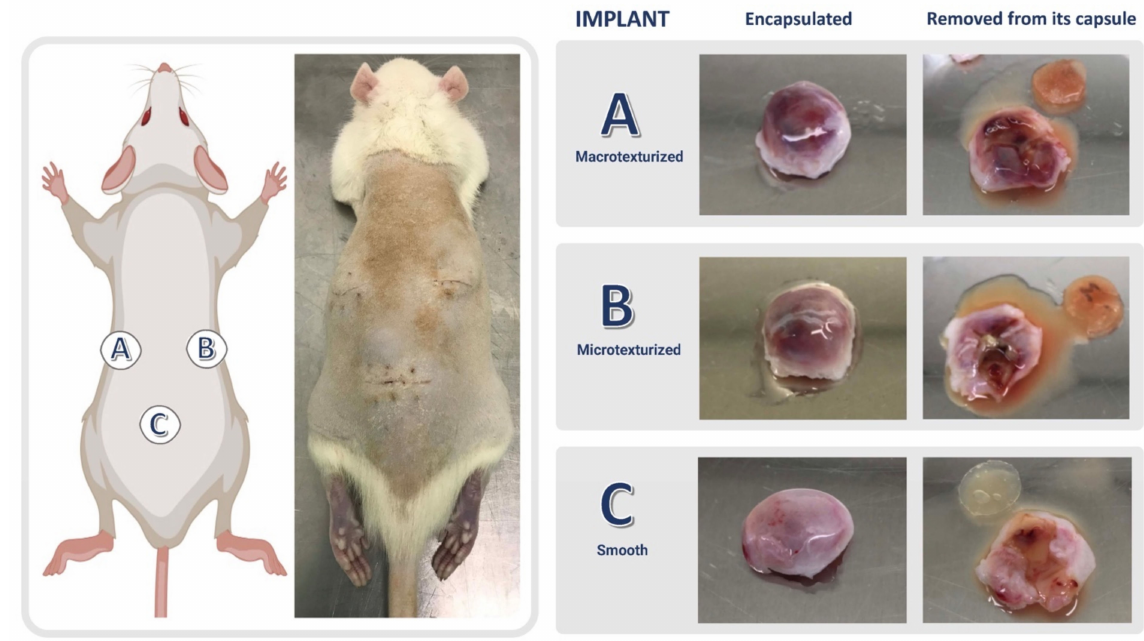
Figure 2. Location of implants in the Wistar rat (( A ) macrotexturized, ( B ) microtexturized, ( C ) smooth). Macroscopic appearance of the capsules containing each type of implant. (Prepared using the BioRender.com